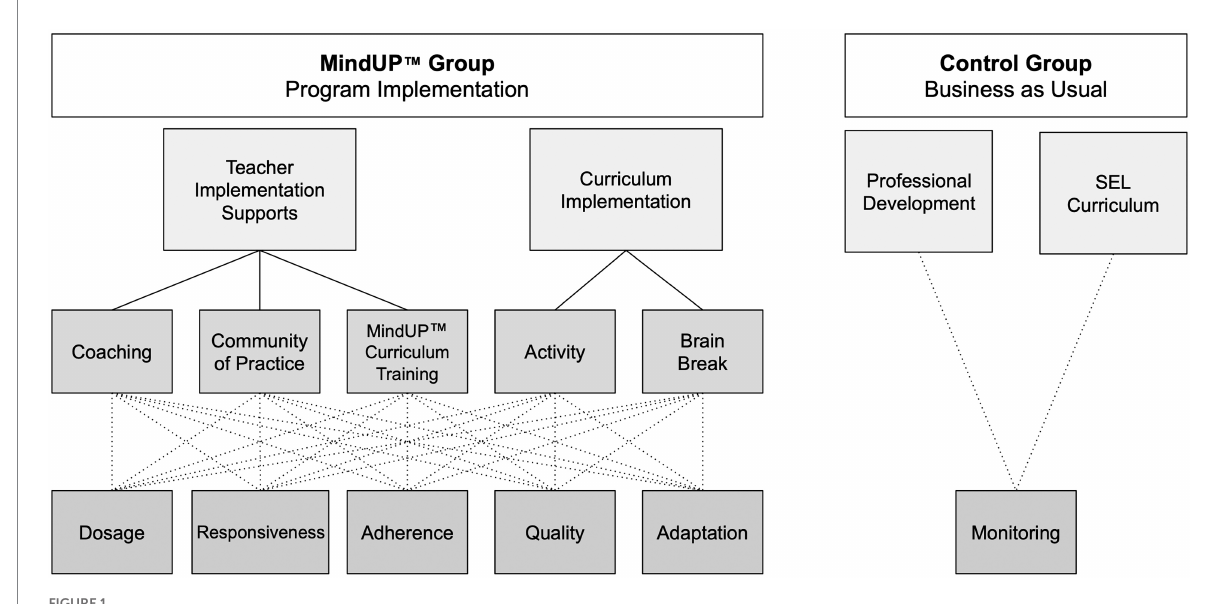
FIGURE 1 Conceptual framework for fidelity of implementation of MindUP ™